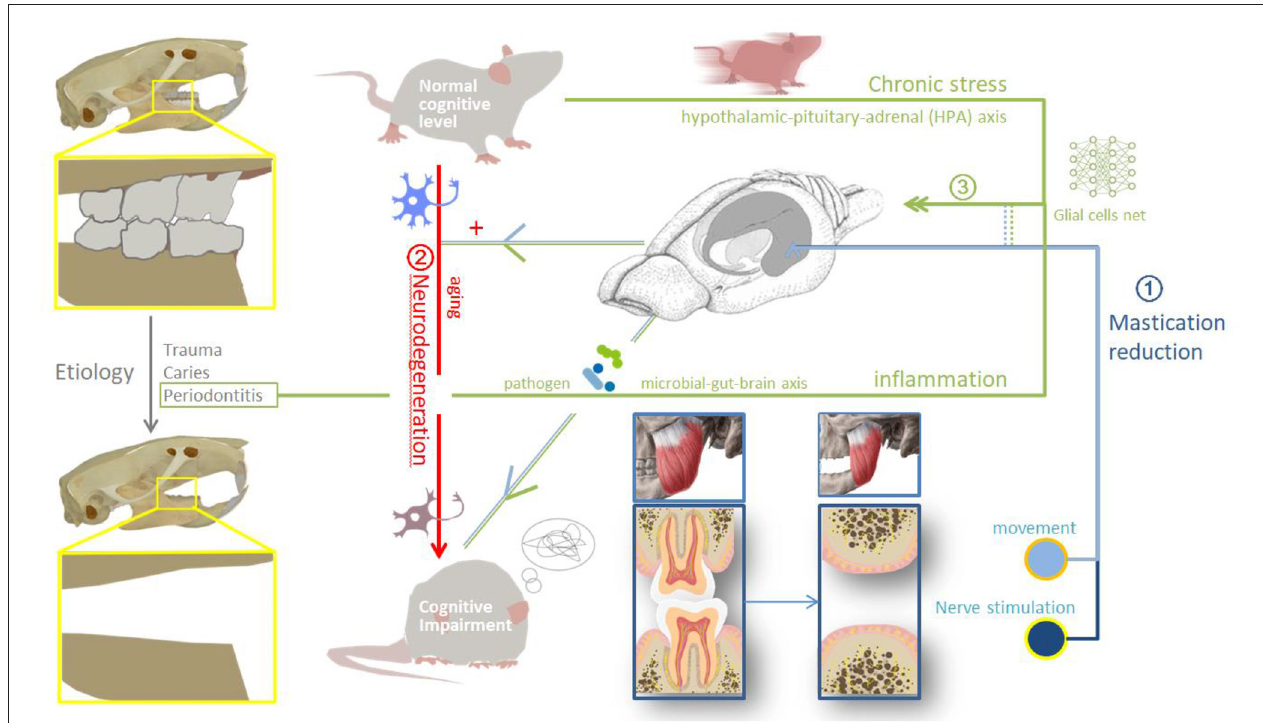
FIGURE 2 | Possible